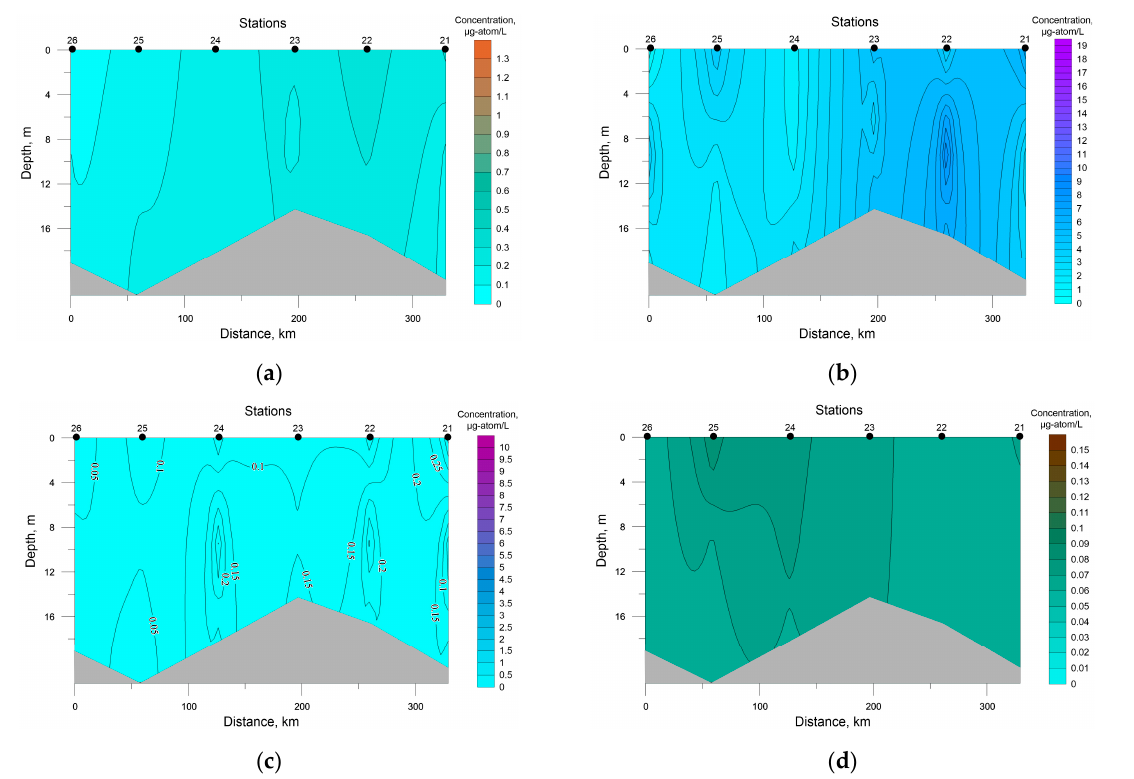
Figure 6. Distribution of nutrients concentration at the investigated transects in the southeastern Barents Sea; ( a ) P-PO 4 , ( b ) Si-SiO 2 , ( c ) N-NO 3 , ( d ) N-NO 2 . Note: The value bar for this figure and Figure 4 is unified.